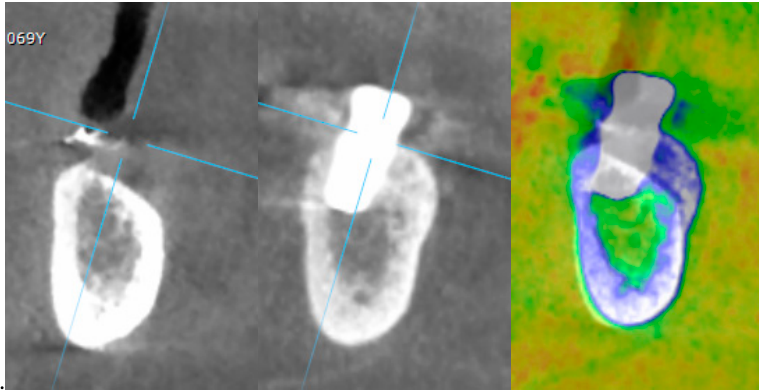
Figure 9. Superimposition of pre- and seven to eight months post-operative CBCT scan.